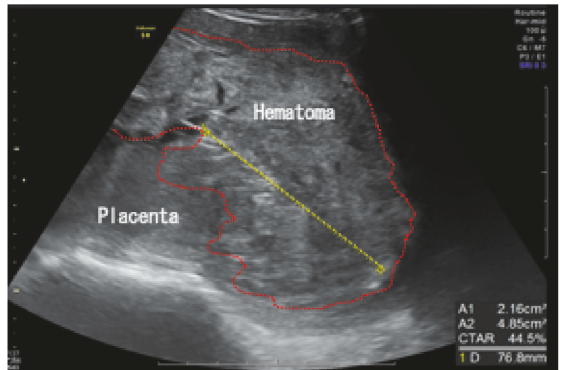
Figure 1: Ultrasound examination revealed a large placental mass with mixed high and low echogenicity measuring approximately 7.6 cm in thickness. The range of the presumed hematoma is indicated by the dotted lines.